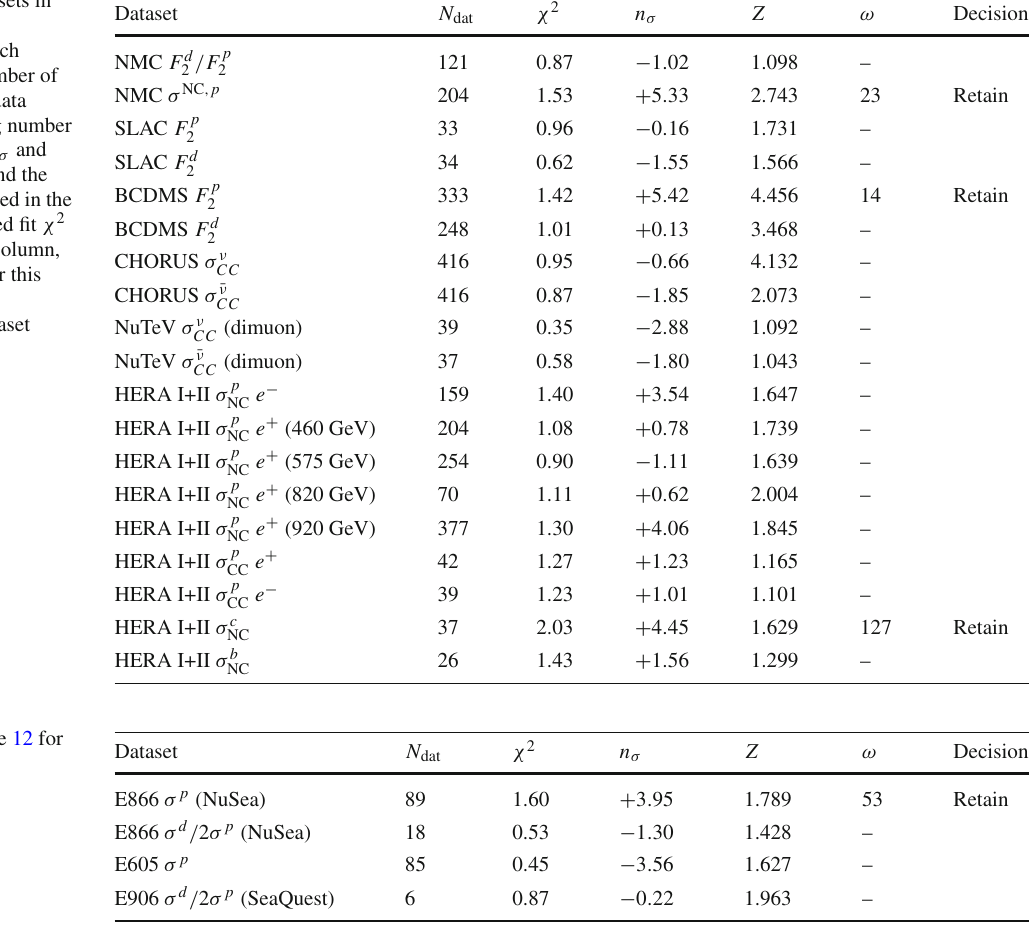
Table 13 Same as Table 12 for fixed-target DY data